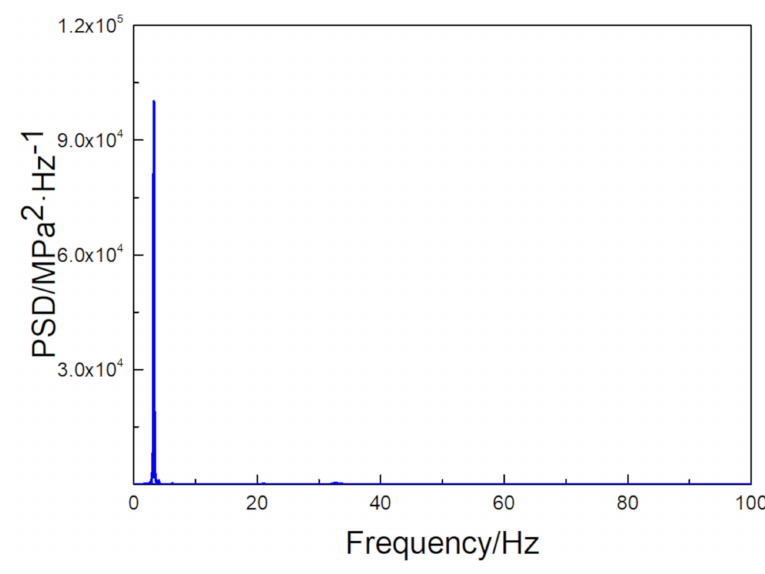
Figure 12. Response stress power spectral density.